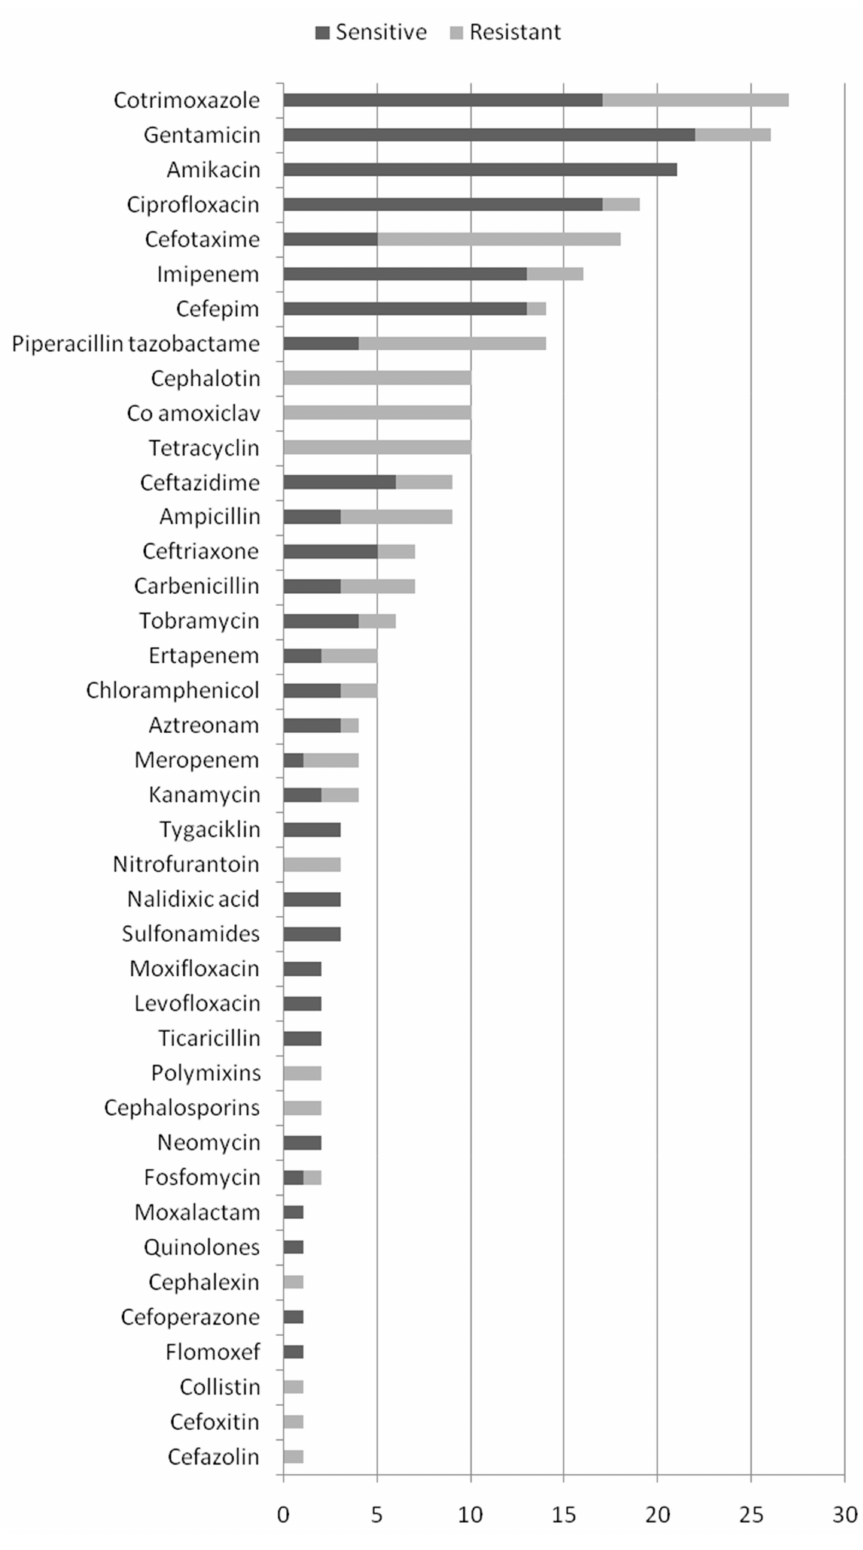
Figure 2. Susceptibility of S. marcescens to